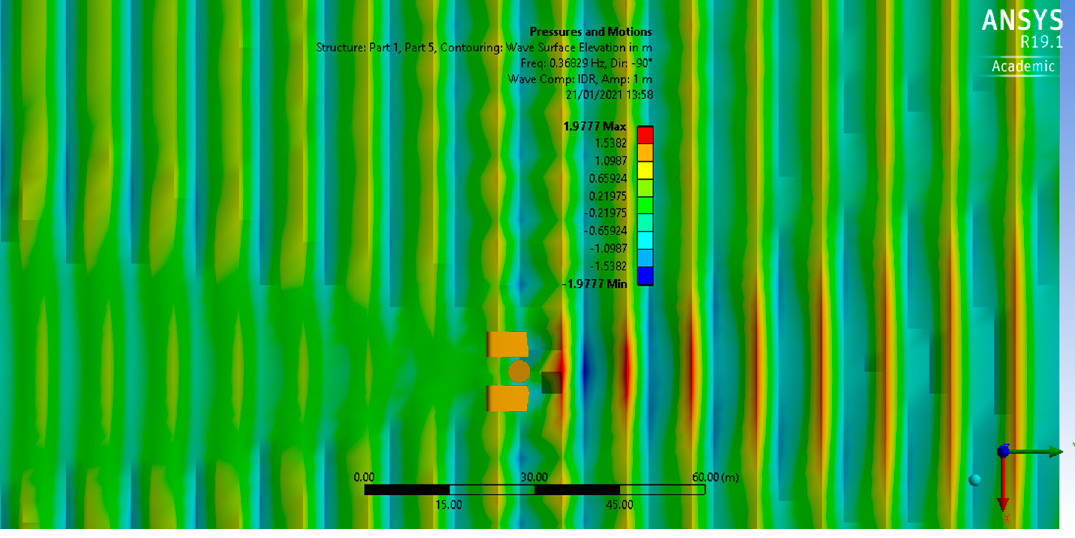
Figure 7. Scheme of the similar principle between the wave energy converter (WEC) WaveRoller from Reference [88] ( left ) and a vertical panel combined with geotextile mattresses from Reference [88] ( right ). The inclusion of WECs in other maritime structures, such as breakwaters, groins or harbour structures, is also an important topic where the knowledge of the scour phenom- ena, and the need to protect the sections where the converter is embedded in these struc- tures is scarce. In Reference [89], a broad review is presented on such converters. In Ref- erence [89], it is seen that often vertical caisson breakwaters may require scour protections